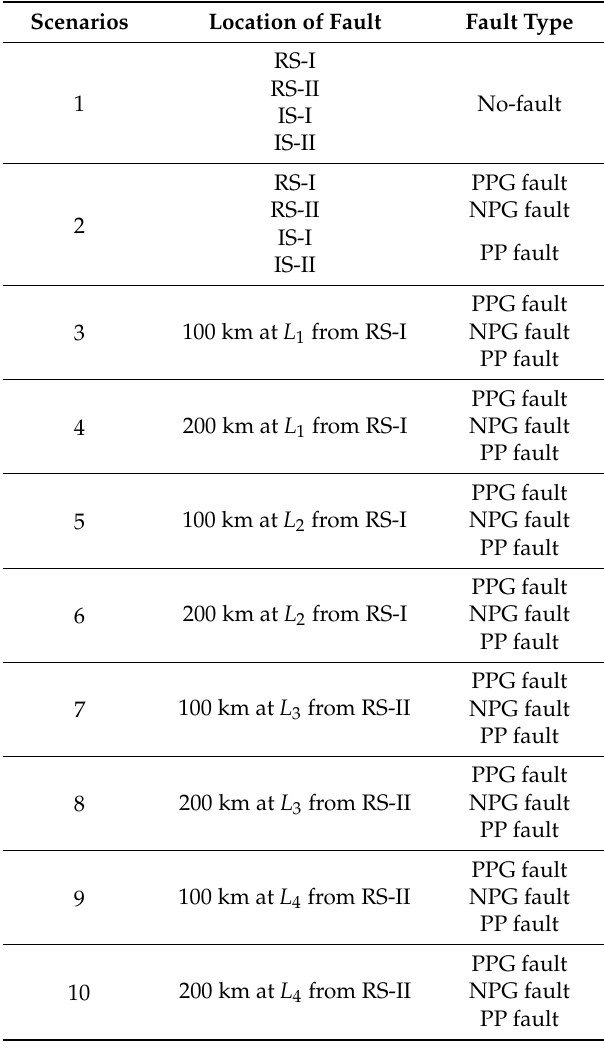
Table 1. Di ff erent case of MT-HVDC test